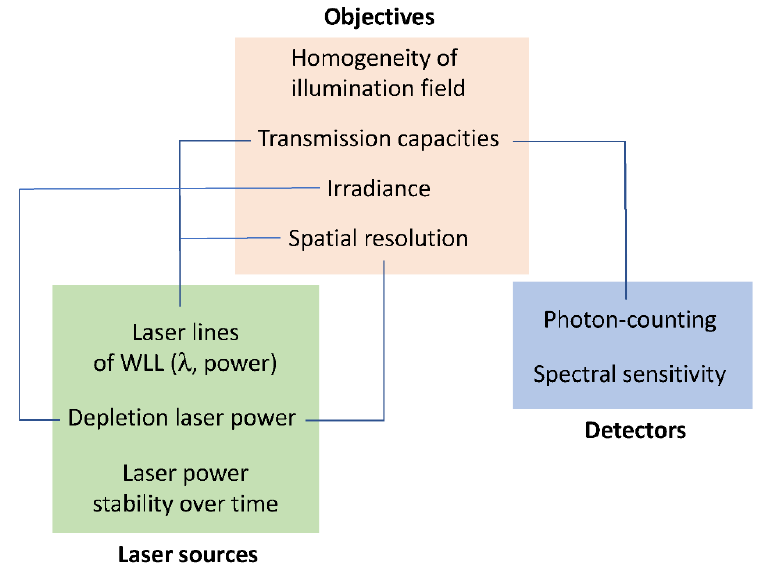
Figure 8. Instrumental characterization for optimization of live-cell imaging. Blue lines indicate 359 relationships between key elements of advanced light microscopies. 360